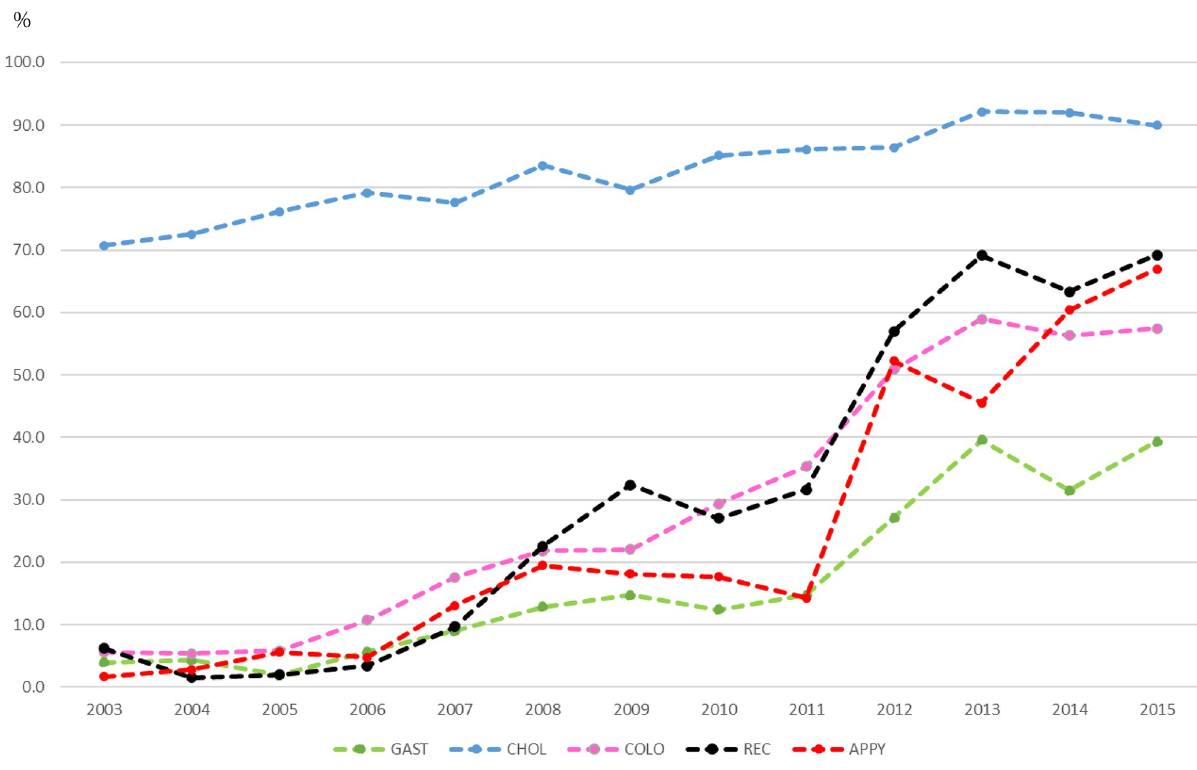
Fig 1. Number of laparoscopic surgeries performed per year